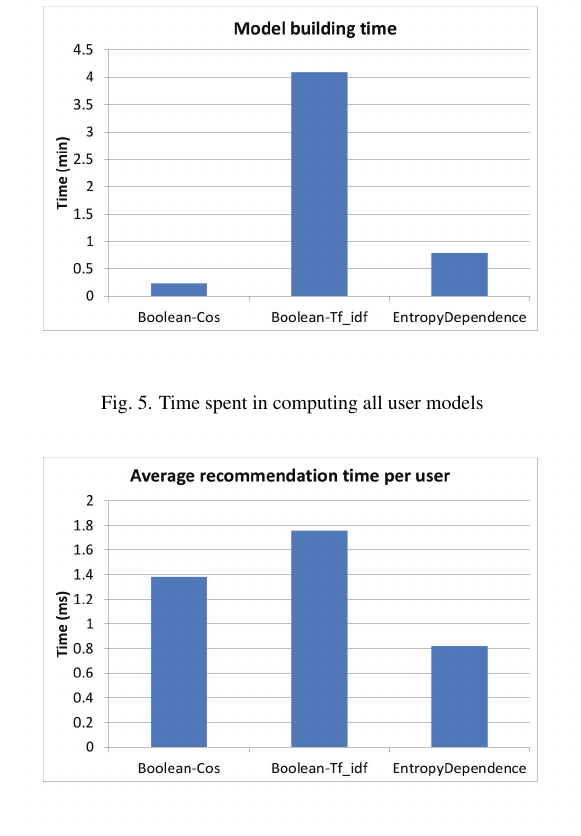
Fig. 6. Time spent in computing all user